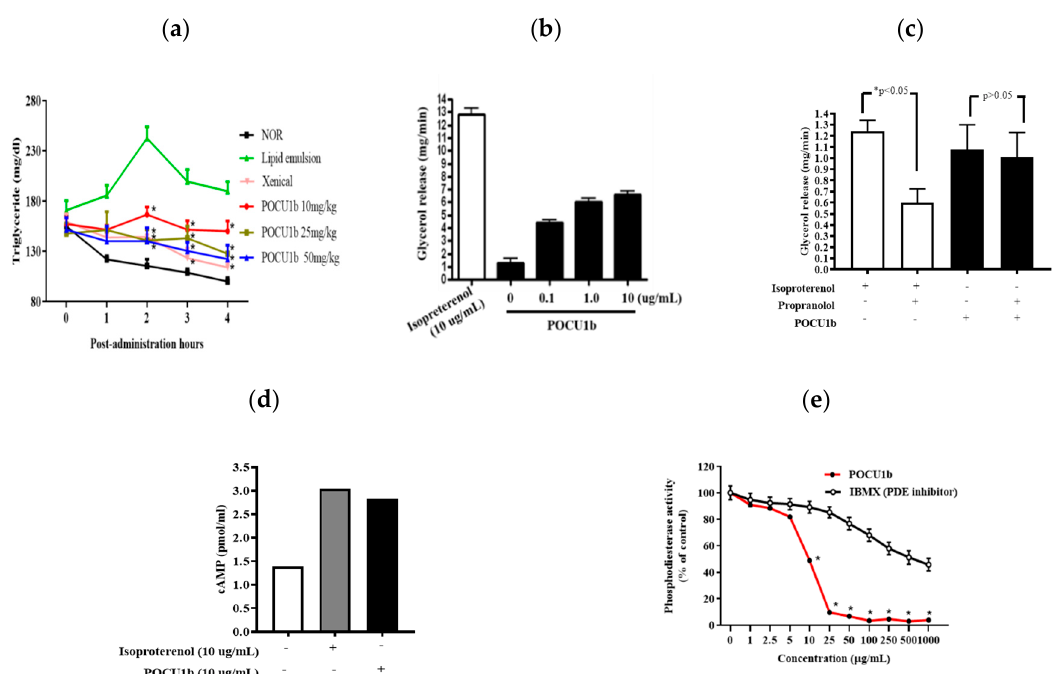
Figure 2. E ff ects of POCU1b on levels of serum triglyceride (TG), glycerol release, cyclic adenosine monophosphate (cAMP), and phosphodiesterase (PDE) activity. ( a ) After acclimation, seven-week-old rats were fasted and administrated with a lipid emulsion with or without POCU1b. Xenical ® (Roche pharma Ltd., Reinach, Swiss, 45 mg / kg) was used as a reference. Blood was collected from the tail vein. POCU1b significantly reduced the serum TG levels at 2, 3, and 4 h after oral administration. * p < 0.05 vs. lipid emulsion. ( b , c ) Rat epididymal adipocytes were incubated with a glycerol reagent and isoproterenol (adrenoceptor agonist), propranolol (adrenoceptor antagonist), or POCU1b at 37 ◦ C for 1 h. The absorbance of the solution at 540 nm was measured using a microplate reader. ( b ) Glycerol release was dose-dependently increased by POCU1b treatment. ( c ) POCU1b-induced glycerol release was not decreased by the co-treatment with propanolol. * p < 0.05 vs. isoproterenol. ( d ) Rat epididymal adipocytes were incubated with ( + ) or without ( − ) isoproterenol or POCU1b for 1 h, transferred into a plate coated with a cAMP-peroxidase conjugate, the enzyme substrate was added, and the colorimetrical density was measured. POCU1b and isoproterenol increased cAMP levels. ( e ) PDE enzyme and POCU1b or IBMX (PDE inhibitor) were incubated with 1 µ M of cAMP. After addition of the termination bu ff er, the Kinase-Glo reagent was added and incubated at room temperature for 10 min. Luminescence at 405 nm was measured. IC 50 values for POCU1b and IBMX were 10.1 µ g / mL and 667.0 µ g / mL, respectively. * p < 0.05 vs. IBMX.